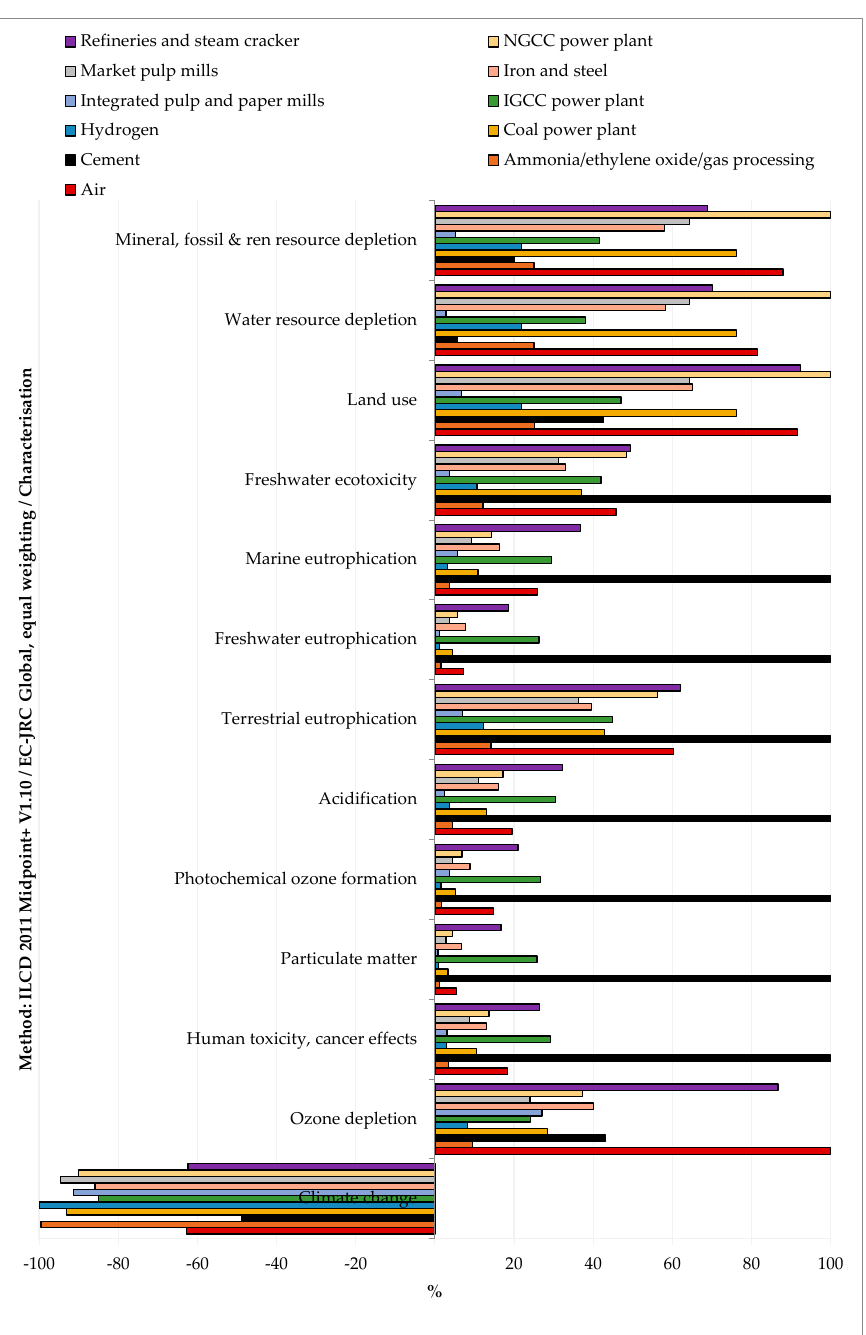
Figure 3. Relative impacts of CO 2 capture (functional unit 1 kg of CO 2 ) from various CO 2 sources.